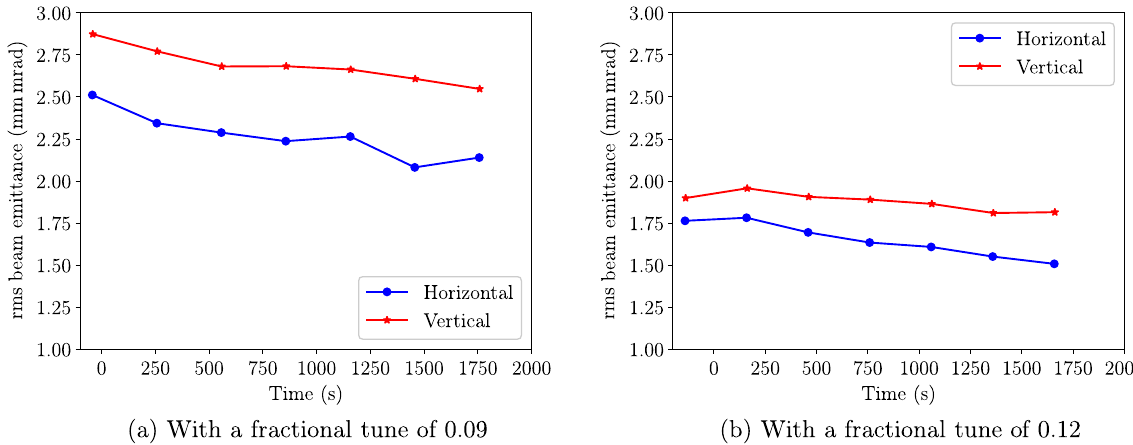
FIG. 12. Transverse emittance blowup due to the space charge effect. A 50% increase was observed with the fractional part of betatron tunes at 0.09 (a) compared to the emittance with the fractional part of betatron tunes later raised to 0.12 (b). The blowup can be seen in the initial values comparing the left and right plots. The horizontal emittance is shown in blue and the vertical emittance is shown in red. The vertical emittance was reported to be higher than the horizontal likely due to the calibration of measurement